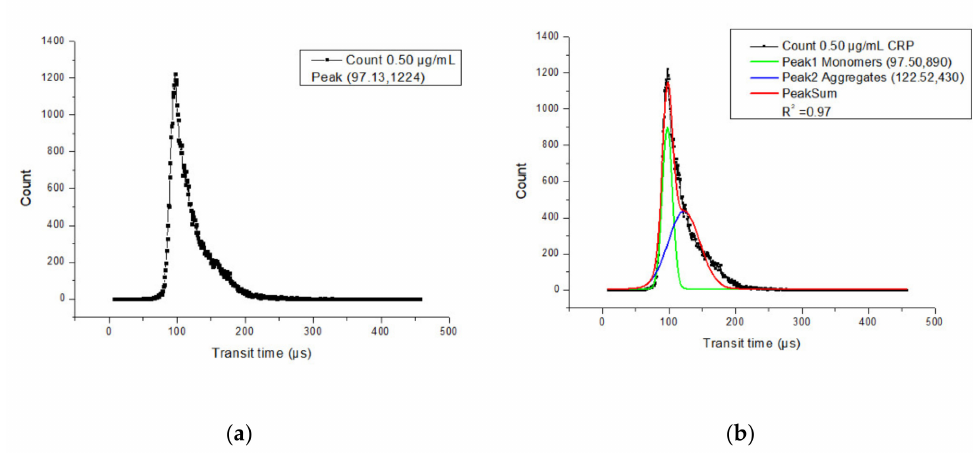
Figure 4. ( a ) Histogram of the transit time of all counts using a 0.50 µ g/mL C-reactive protein (CRP) measurement. Each square was the count number of the corresponding transit time. ( b ) Histogram of the transit time of all counts using 0.5 µ g/mL CRP with 2-order Gaussian fitting.